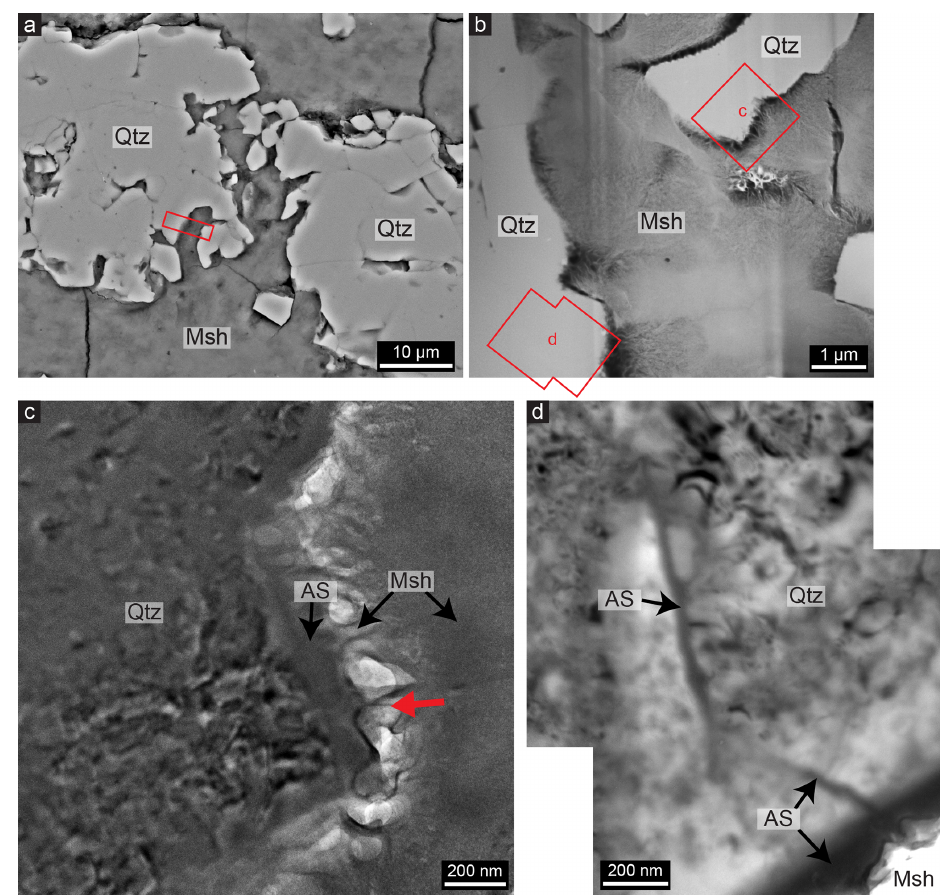
Figure 7. (a) SEM image of weathered quartz (Qtz) surrounded by magnesium silicate hydrate (Msh); the rectangle indicates the location of the FIB thin film studied with TEM. (b) Scanning transmission electron microscopy (STEM) image giving an overview of the FIB thin film, showing the locations of (c) and (d) as well as the presence of quartz within the fibrous cement. (c) Bright-field TEM image showing that an amorphous silica (AS) layer of 100–200nm is present around crystalline quartz that is surrounded by magnesium silicate hydrate cement. Note the presence of fringes indicating crystallinity in the quartz grain and the lack of those in the amorphous silica layer. The fibrous magnesium silicate hydrate is attached to the amorphous silica (e.g. at the red arrow), although pore spaces (the bright areas) are present in between. (d) Bright-field TEM image showing that a layer of amorphous silica of 30nm is present between two quartz grains; it starts at the thicker amorphous layer on the outer boundary of quartz (lower right) where magnesium silicate hydrate is present, like the layer in (c) , and follows the grain boundary for about 1.4µm inwards, after which it